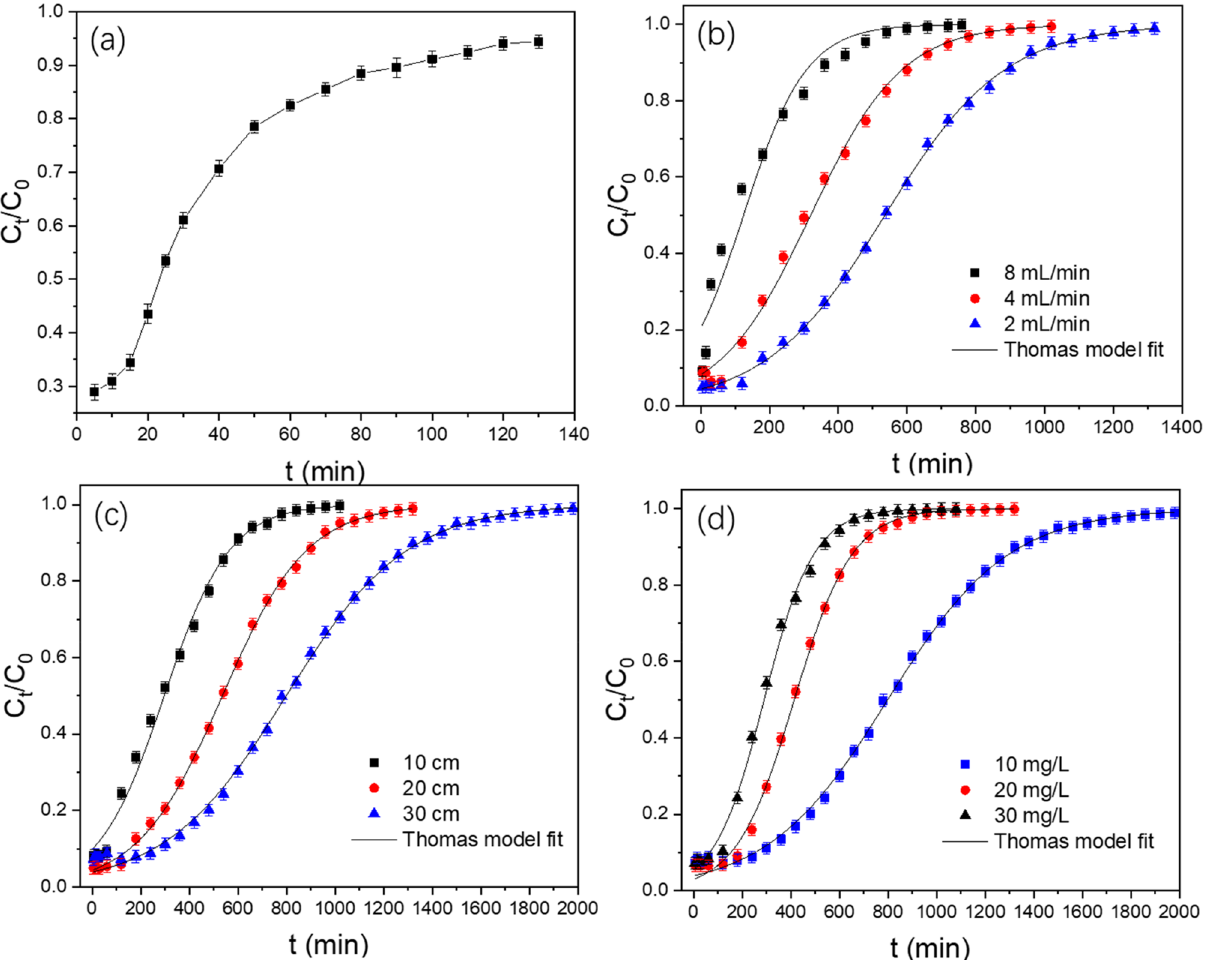
Figure 8. ( a ) Breakthrough curves for raw sand (blank control), bed depth, 20 cm; Sb(III), 10 mg/L, flow rate 8 mL/min. ( b ) Breakthrough curves for GAD with different hydraulic loading rates, 20 cm, 10 mg/L. ( c ) Breakthrough curves for GAD with different bed depths, 2 mL/min, 10 mg/L. ( d ) Breakthrough curves for GAD with different feed concentrations, 2 mL/min, 30